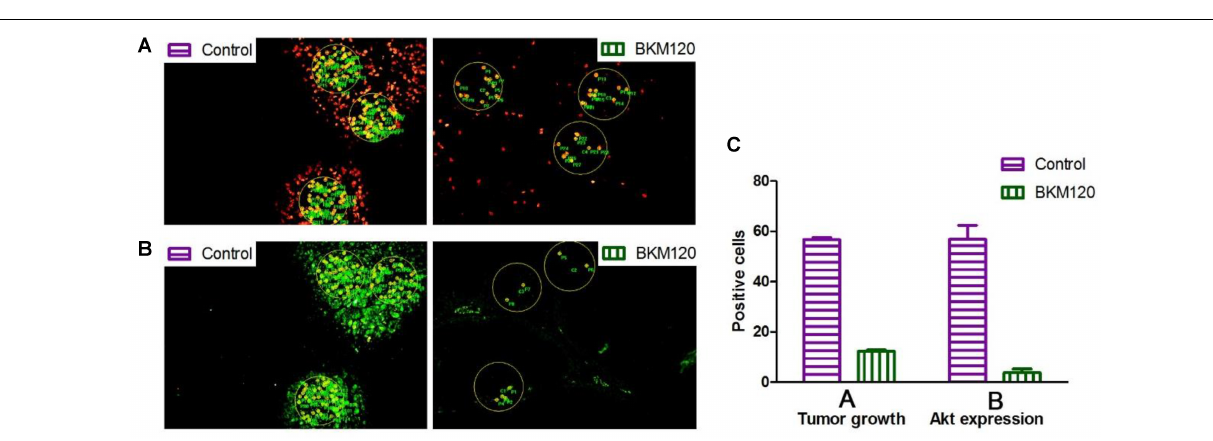
FIGURE 5 | Image analysis to access cell proliferation and protein expression. (A) The proliferating cells were labeled with EdU in both control and BKM120 treated groups. (B) The expression of phosphorylated Akt were stained by immunofluorescence in both control and BKM120 treated groups. (C) Quantitative analysis of positive cells per area unit regarding of the proliferating cells and the expression of phosphorylated Akt in both control and BKM120 treated